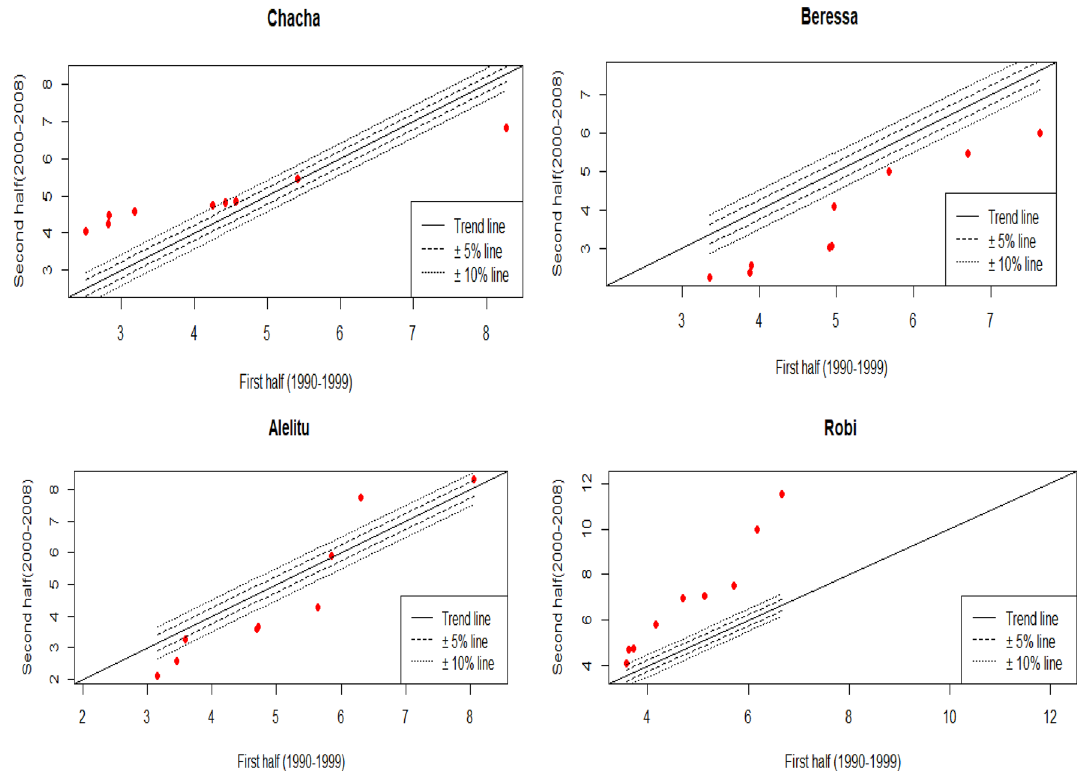
Fig. 2 Innovative trend analysis graph for streamflow: The path of red dots along the trend line is indicating the increasing /decreasing trend of precipitation between 1990 and